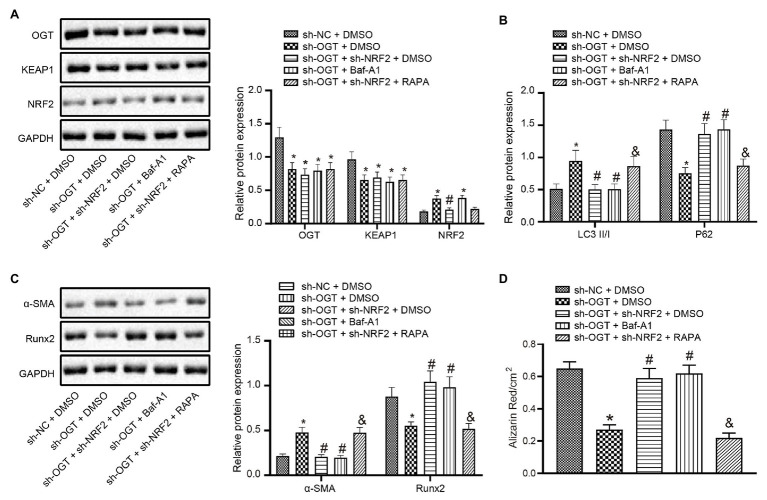
OGT inhibits autophagy through the KEAP1/NRF2 axis and accelerates high phosphate-induced VC in 5/6 nephrectomy (5/6 Nx) rats. (A) Western blot analysis of protein levels of OGT, KEAP1, and NRF2 normalized to GAPDH in rats. (B) Western blot analysis of autophagy-related proteins LC3II/I, and P62 proteins normalized to GAPDH in rats. (C) Western blot analysis of calcification-related proteins Runx2 and α-SMA normalized to GAPDH in rats. (D) Quantitative analysis of ARS staining showing calcified nodules in thoracic aorta of rats. Black arrows indicate calcified nodules. *p < 0.05 vs. rats treated with sh-NC + DMSO. #p < 0.05 vs. rats treated with sh-OGT + DMSO. &p < 0.05 vs. rats treated with sh-OGT + sh-NRF2 + DMSO (n = 8 rats in each group).